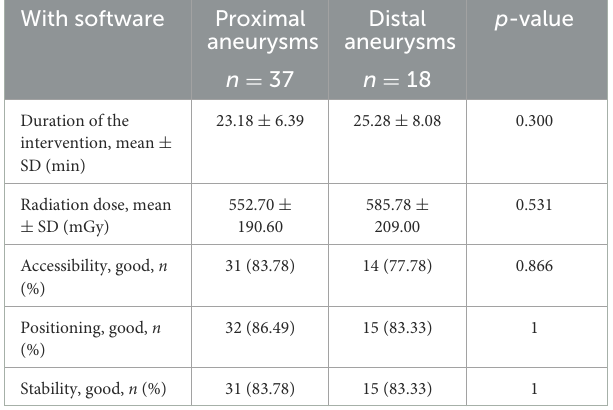
TABLE 5 Comparison of microcatheter shaping efficiency of proximal and distal aneurysms by software-assisted. With